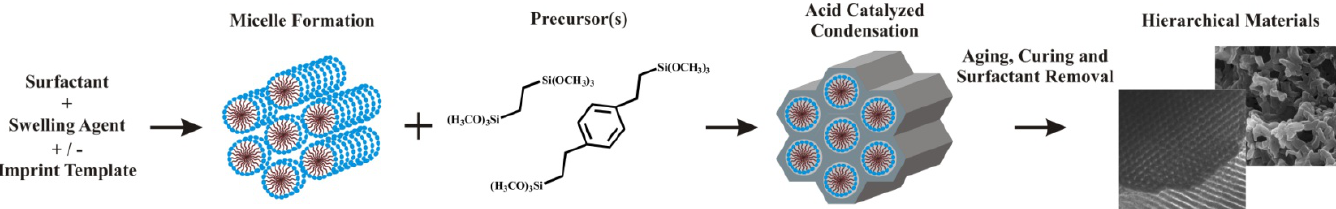
Figure 2. Synthesis of hierarchical macro/mesoporous organosilicate